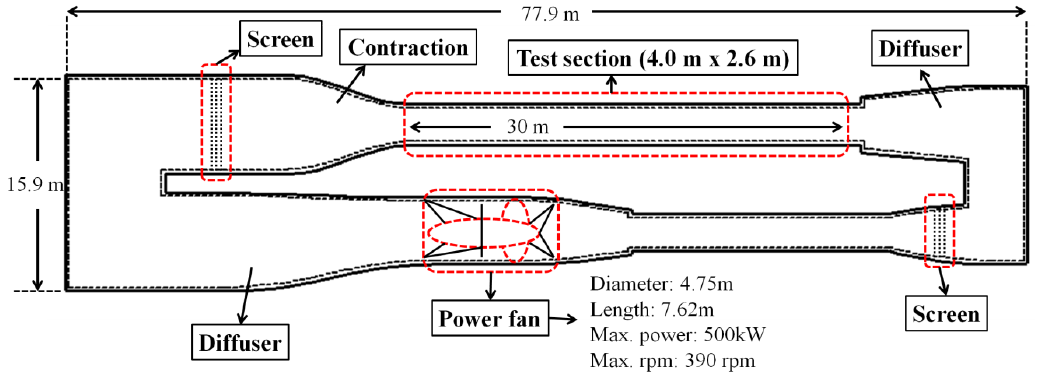
Figure 12. Sketch of the ABRI wind tunnel.